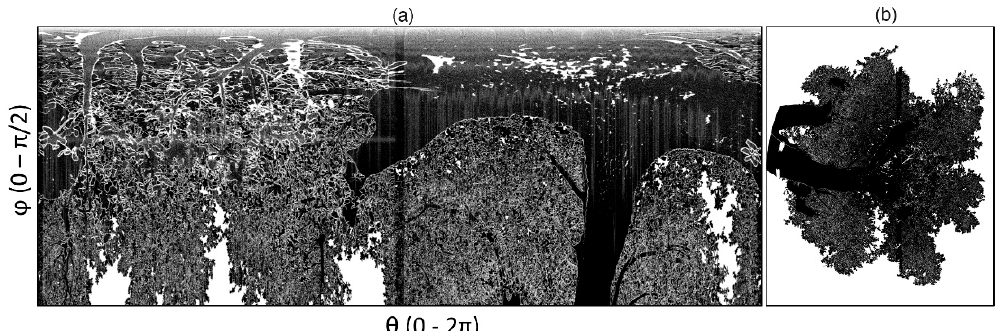
Figure 10. Angular grid ( a ) and its transformation into TLS-SHI ( b ).